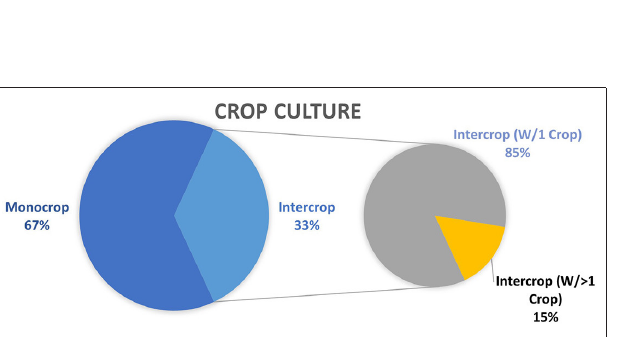
FIGURE 2 | Number of fields surveyed each day between August 13th and December 12th, 2019 in Busia, Kenya.